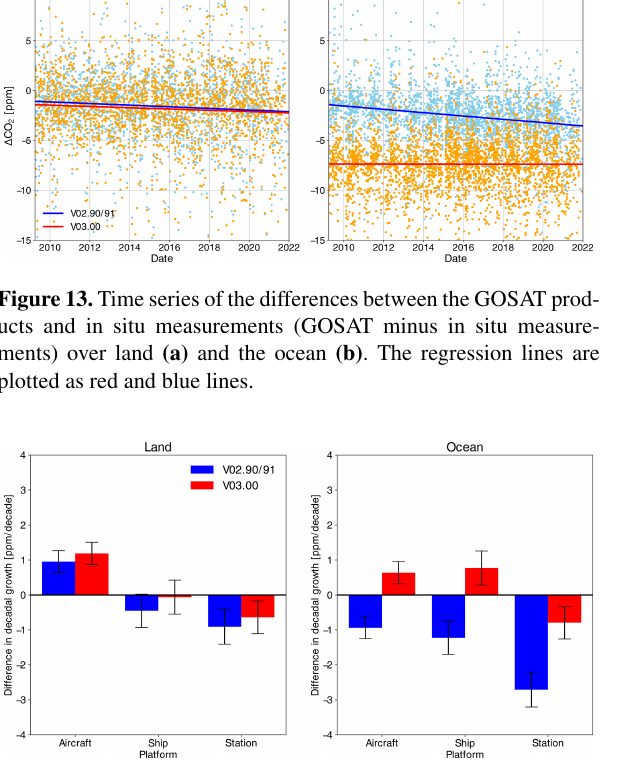
Figure 14. Differences in the decadal growths of CO 2 between the GOSAT product and each in situ measurement